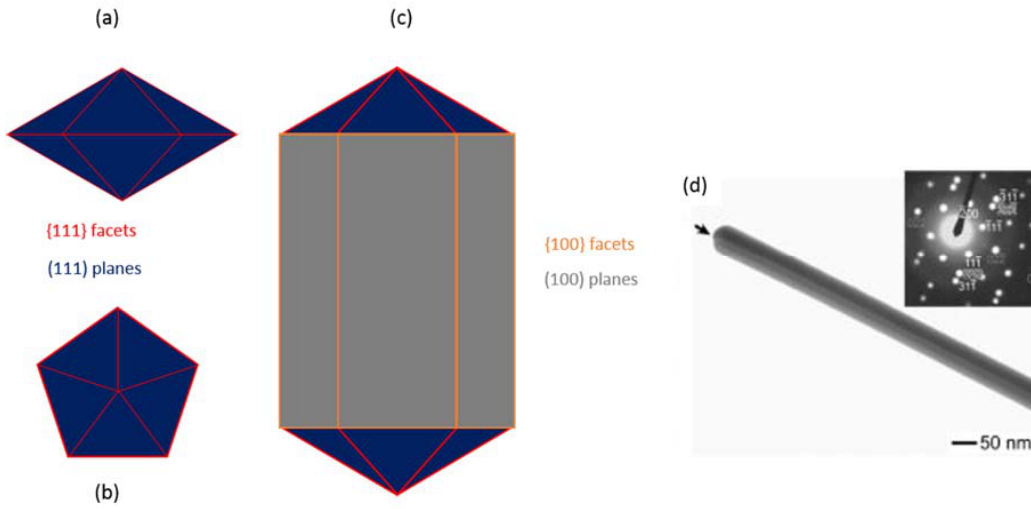
Figure 1. Crystal structure of AgNWs: ( a ) side and ( b ) top view of a multiply twinned particle of decahedral structure with {111} facets and (111) planes highlighted; ( c ) side view of an axially elongated crystal grown by passivation of the {100} facets; ( d ) typical TEM image of a single AgNW [Reproduced from [26] with permission. Copyright (2002) Wiley].